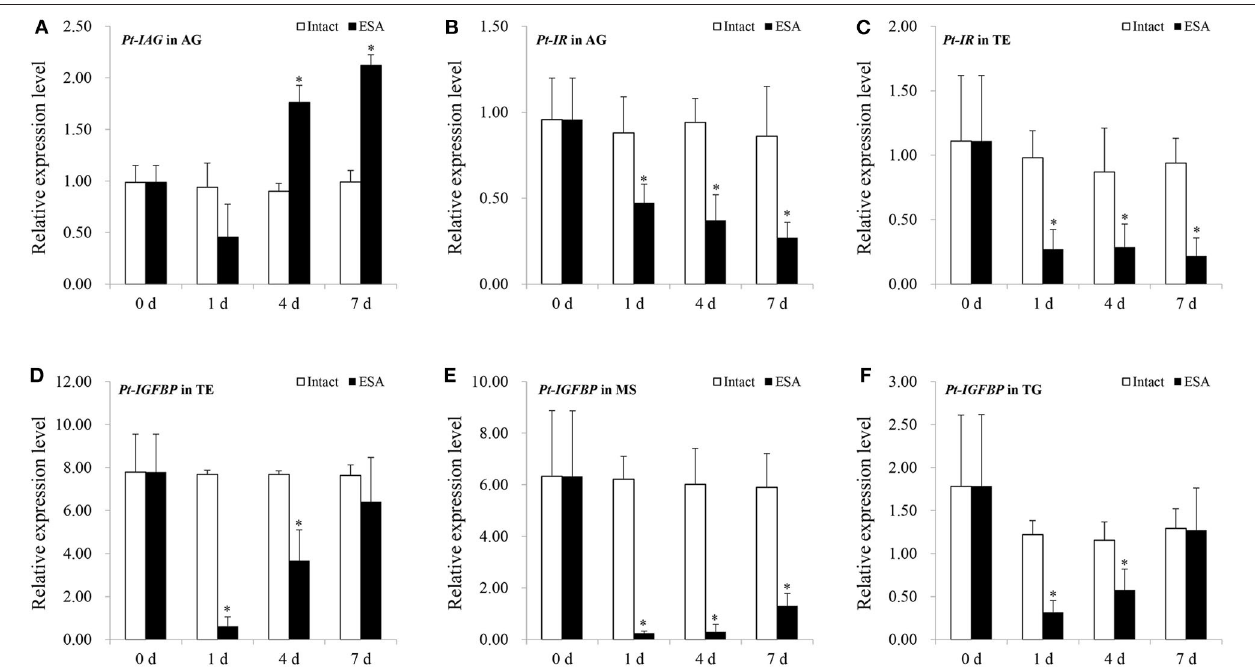
FIGURE 3 | Effects of eyestalk ablation (ESA) surgery on the gene expression of insulin-like androgenic gland hormone of Portunus trituberculatus ( Pt-IAG ) in the androgenic gland (AG) (A) , Pt- insulin receptor ( IR ) in the AG (B) , and testis (C) , and Pt- insulin-like growth factor-binding protein ( IGFBP ) in the testis (D) , muscle (E) , and thoracalia ganglia (F) . Bars represent mean ± SEM ( n = 4). ** P < 0.01 represent values statistically different from those of the control groups (Student’s t